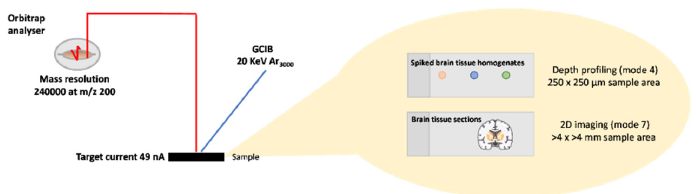
200 mass resolution setting. Data was collected between 75 and 1125 Da for each spectrum from spots freeze-dried onto a glass microscope slide.